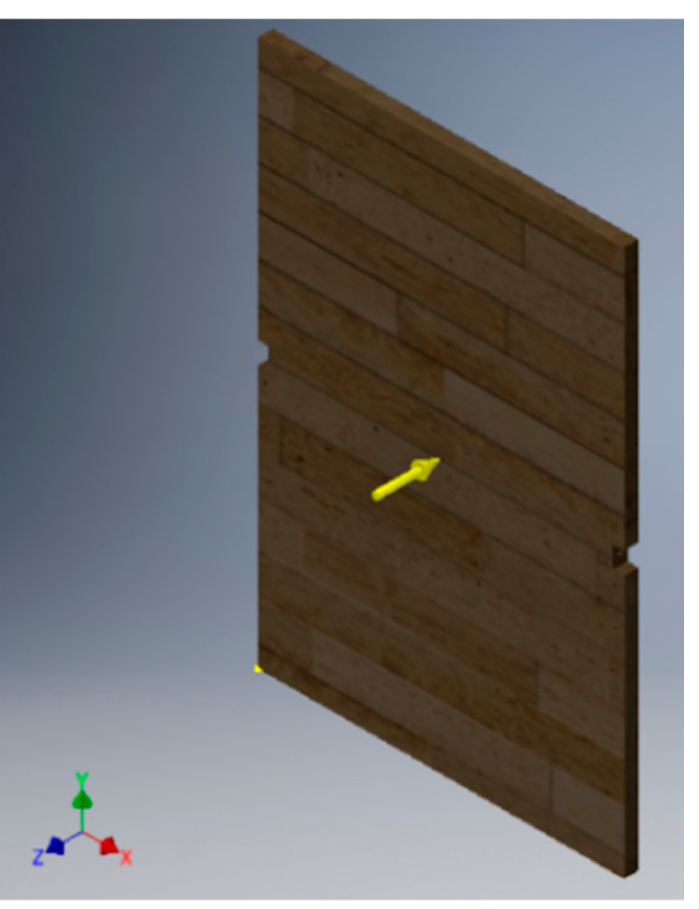
Figure 4. Overview of the force applied on the platform. The force is applied at the centre of the platform. From the simulation, it can be observed that the maximum stress is accumulated at the drilled hole where the platform is fixed. By observing the colour indicators for all four conditions, it is found that the stress ranges from 8 to 12 MPa, which actually exceeds the tensile strength of Cedar wood. However, apart from this small region, the stress across the entire platform is close to zero and negligible. Referring to load condition (d) where the highest force is applied, the maximum displacement is 1.447 mm, which is a relatively small value when the size of the platform is considered. The minimum safety factor is shown to be 2.38. Hence, the design of the platform is still considered structurally